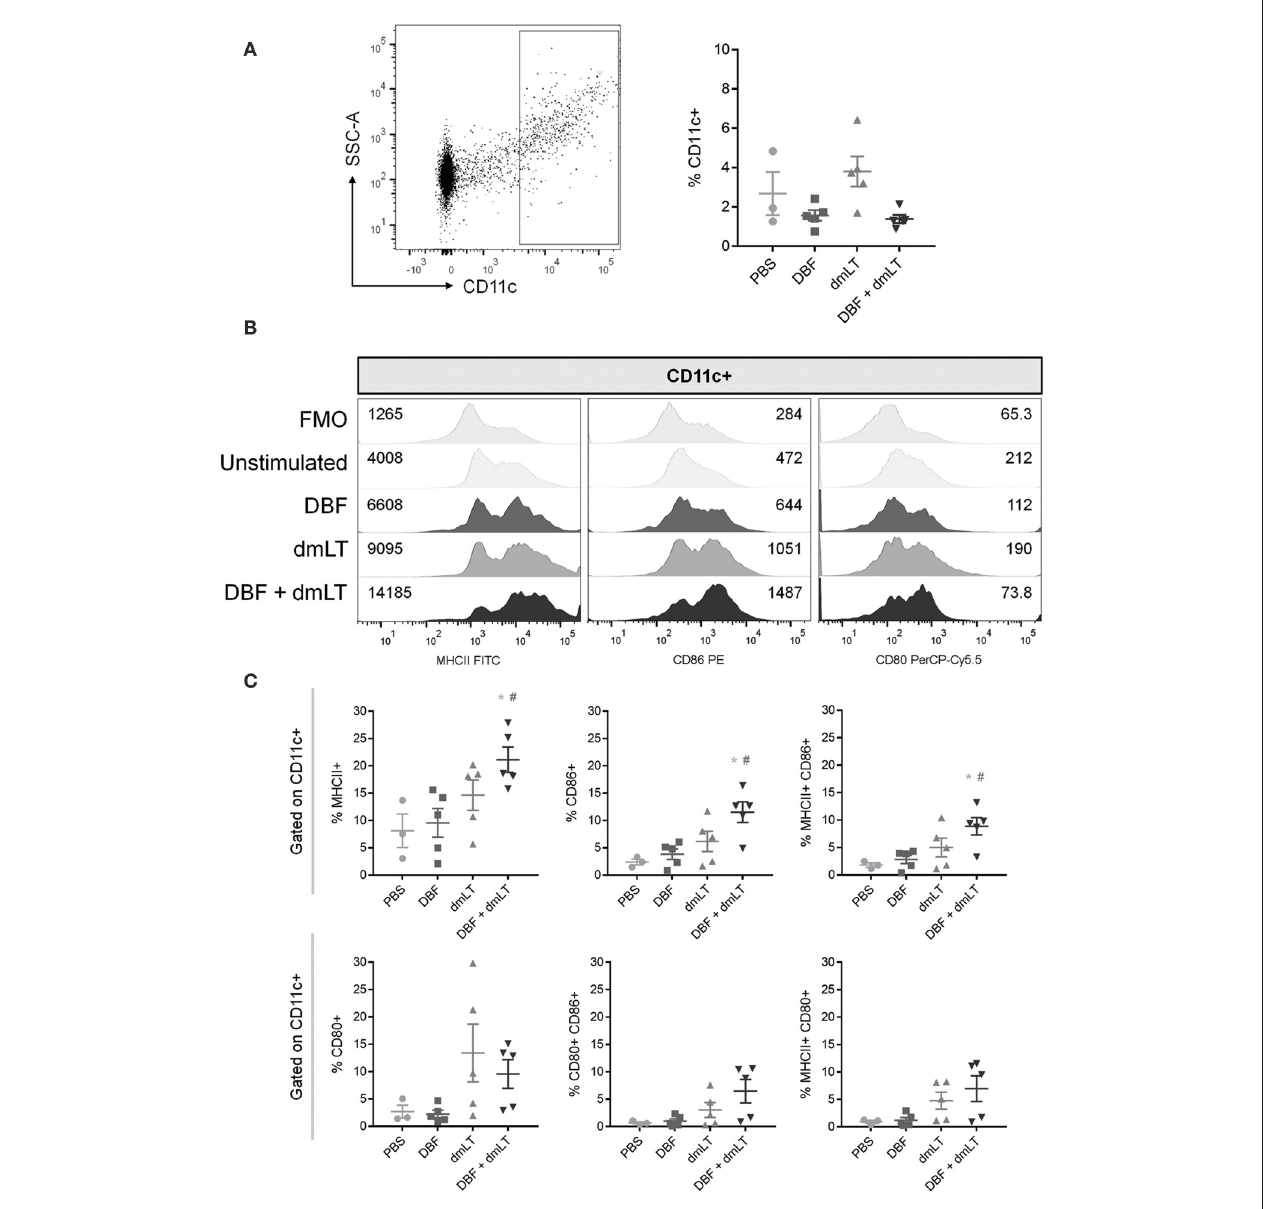
FIGURE 1 | Dendritic cell populations in NALT post-immunization. Nasal-associated lymphoid tissue (NALT) was harvested from BALB/c mice 6h after immunization with PBS, DBF, dmLT, and the combination DBF + dmLT. Cells in NALT were isolated and stained as described in Materials and Methods. (A) Dendritic cells were recognized by positive CD11c labeling (left). The percentage of CD11c + cells was measured in NALT (right). (B) Expression of MHCII, CD86, and CD80 from a representative sample for each treatment. Fluorescence minus one (FMO) controls are shown for comparison. Numbers present inside the grids indicate median fluorescence intensity (MFI). (C) CD11c + populations show differential percentages MHCII, CD86, and MHCII CD86 double positive cells. Each point represents a different individual. Error bars indicate standard deviation. Statistical significance was analyzed with an ordinary one-way ANOVA with a Tukey post-hoc test. All comparisons tested with an α value of 0.05. * p < 0.05 vs. PBS, # p < 0.05 vs. DBF.